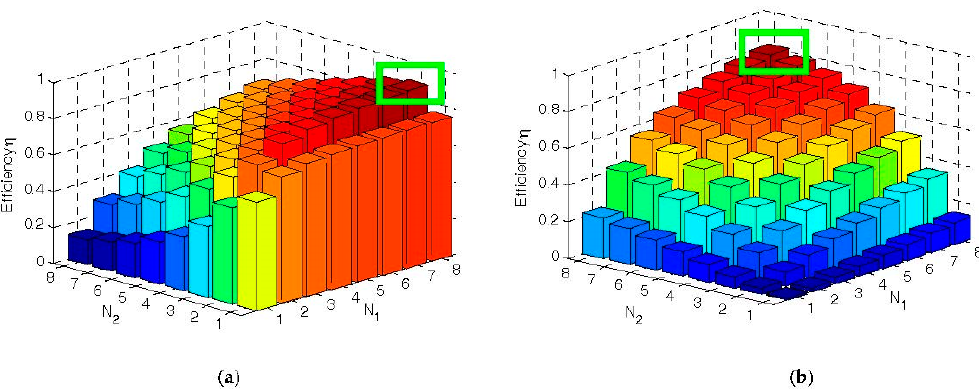
Figure 6. Efficiency vs. number of turns N 1 and N 2 considering SP topology ( a ) and Series-Series (SS) topology ( b ).